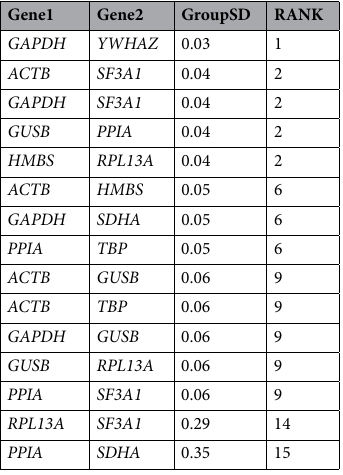
Table 2. NormFinder candidate RG combination stability output.